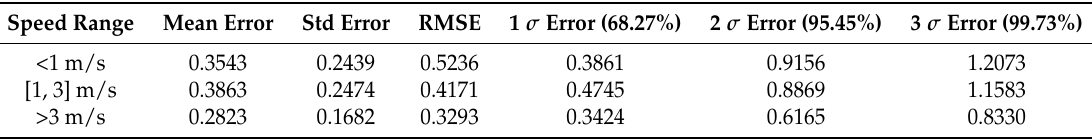
Table 8. Dynamic experimentation synthetic results in